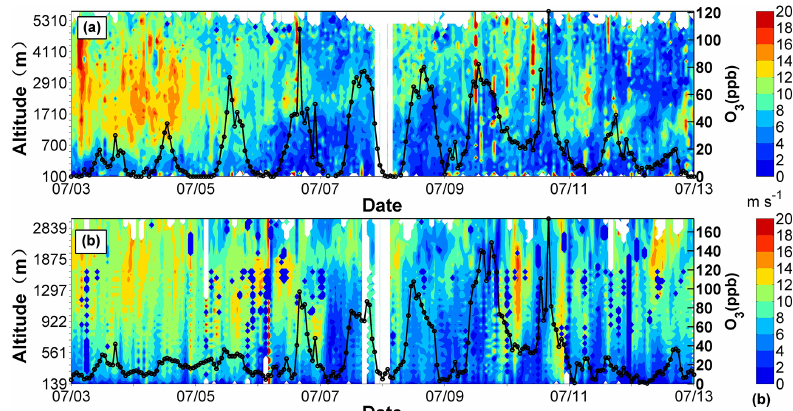
Figure 4. The profile evolution of horizontal wind speed from 3 to 13 July. The solid black lines are the surface ozone concentrations at (a) 59284 and (b) 59486 wind profile radar stations.